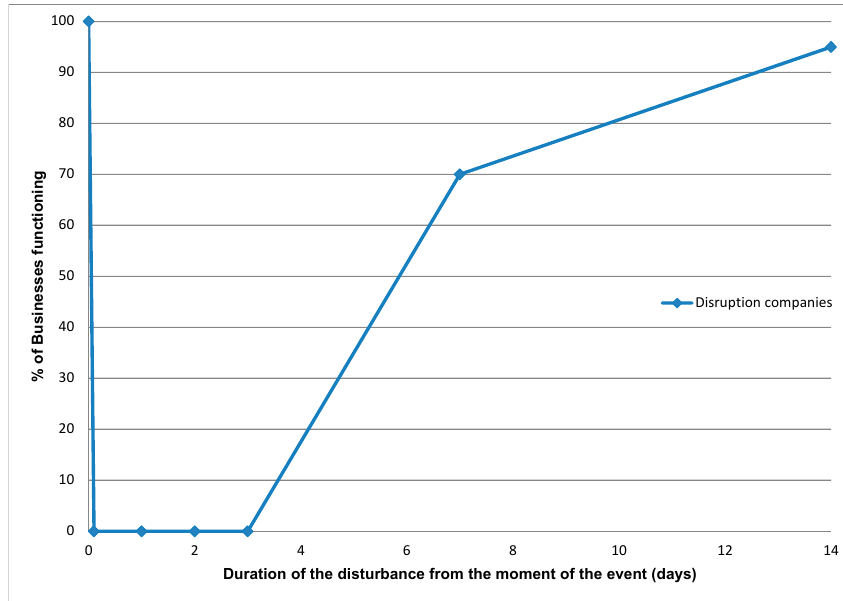
Figure 7. Disruption over time for the storyline scenario. The total disruption can be assessed by calculating the area between the 100% level and the blue curve. The total disruption is 34% of the total functioning businesses